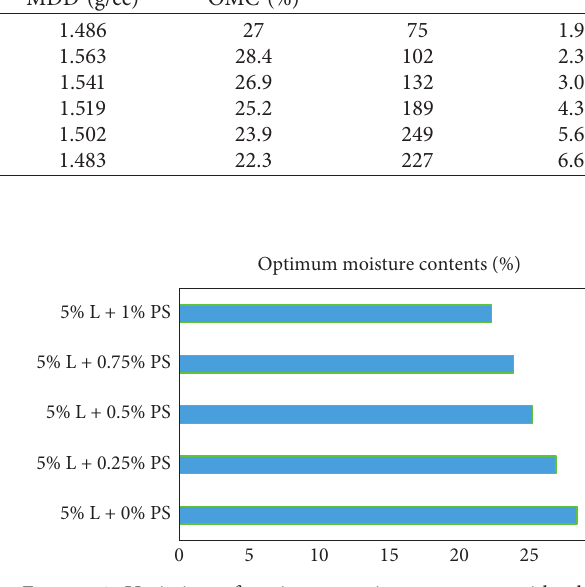
Table 4: Summary of the effects of lime and plastic on geotechnical properties of expansive soil. Addition proportion